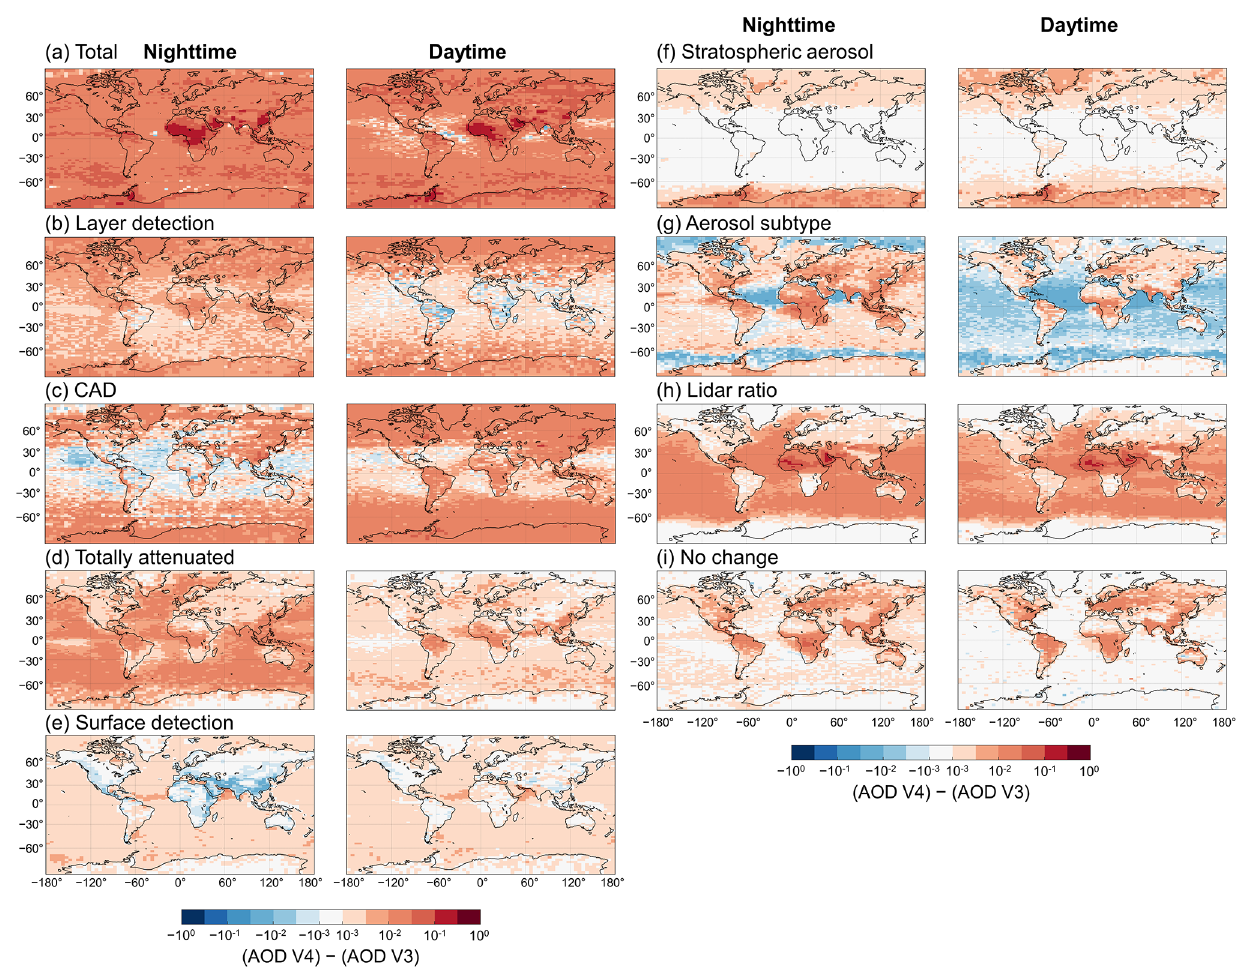
Figure 15. Global maps of mean AOD differences between V3 and V4 for each factor categorized in Fig. 14 from 2007 to 2009: (a) total, (b) layer detection, (c) CAD, (d) totally attenuated, (e) surface detection, (f) stratospheric aerosol, (g) aerosol subtype, (h) lidar ratio, and (i) no changes. Left and right columns are for nighttime and daytime,